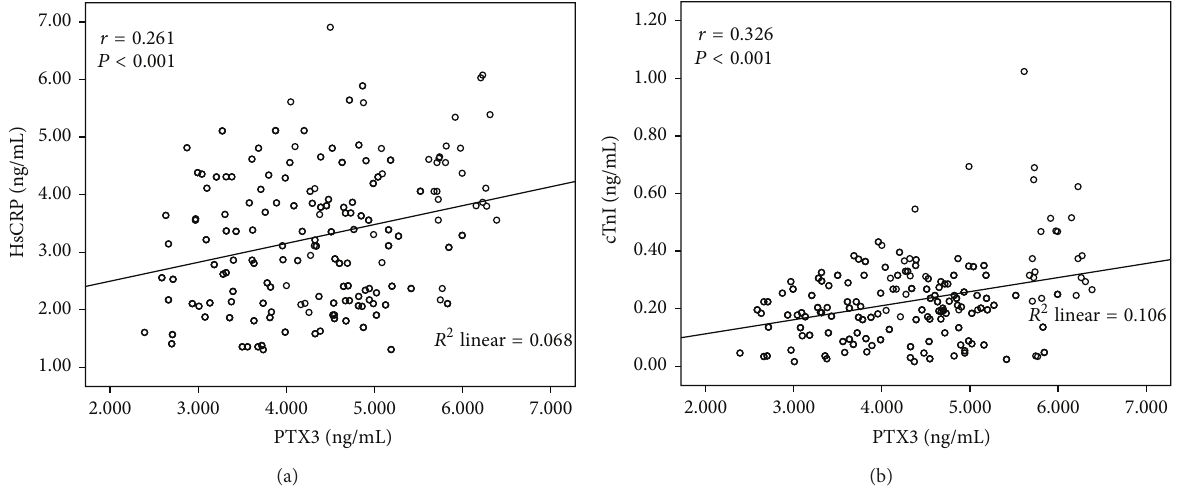
Figure 2: The relationship between PTX3 and hsCRP (a) and cTnI (b) by correlation